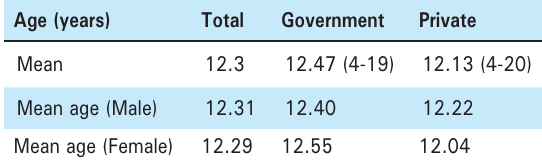
Table 1. Age distribution of the children